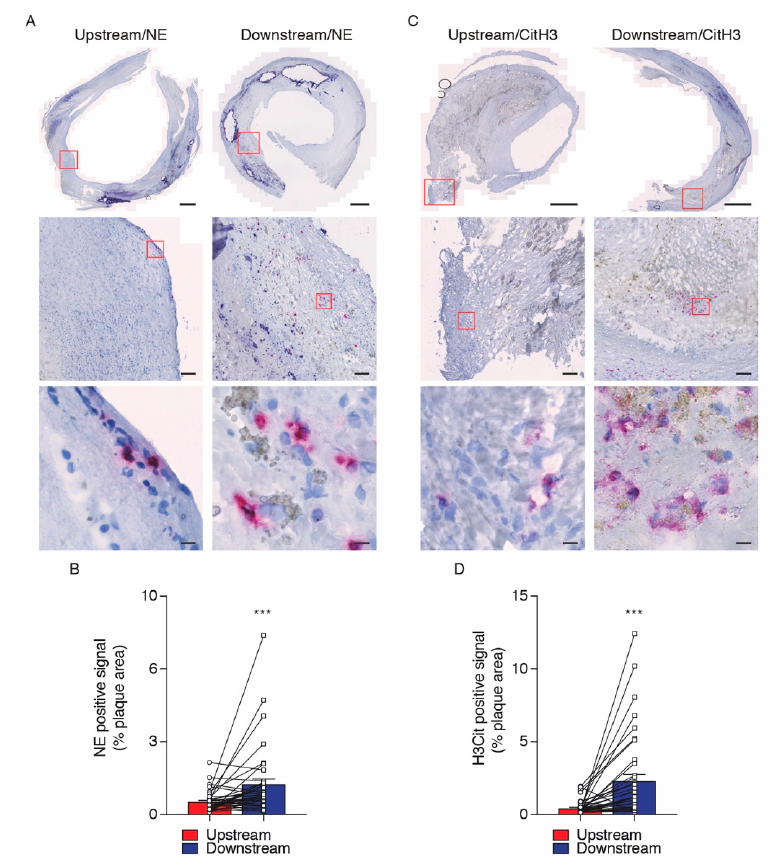
Figure 2. Expression of neutrophil elastase (NE) and citrullinated histone-3 (H3Cit) on upstream versus downstream blood flow plaque regions of human carotid artery. Representative microphotographs